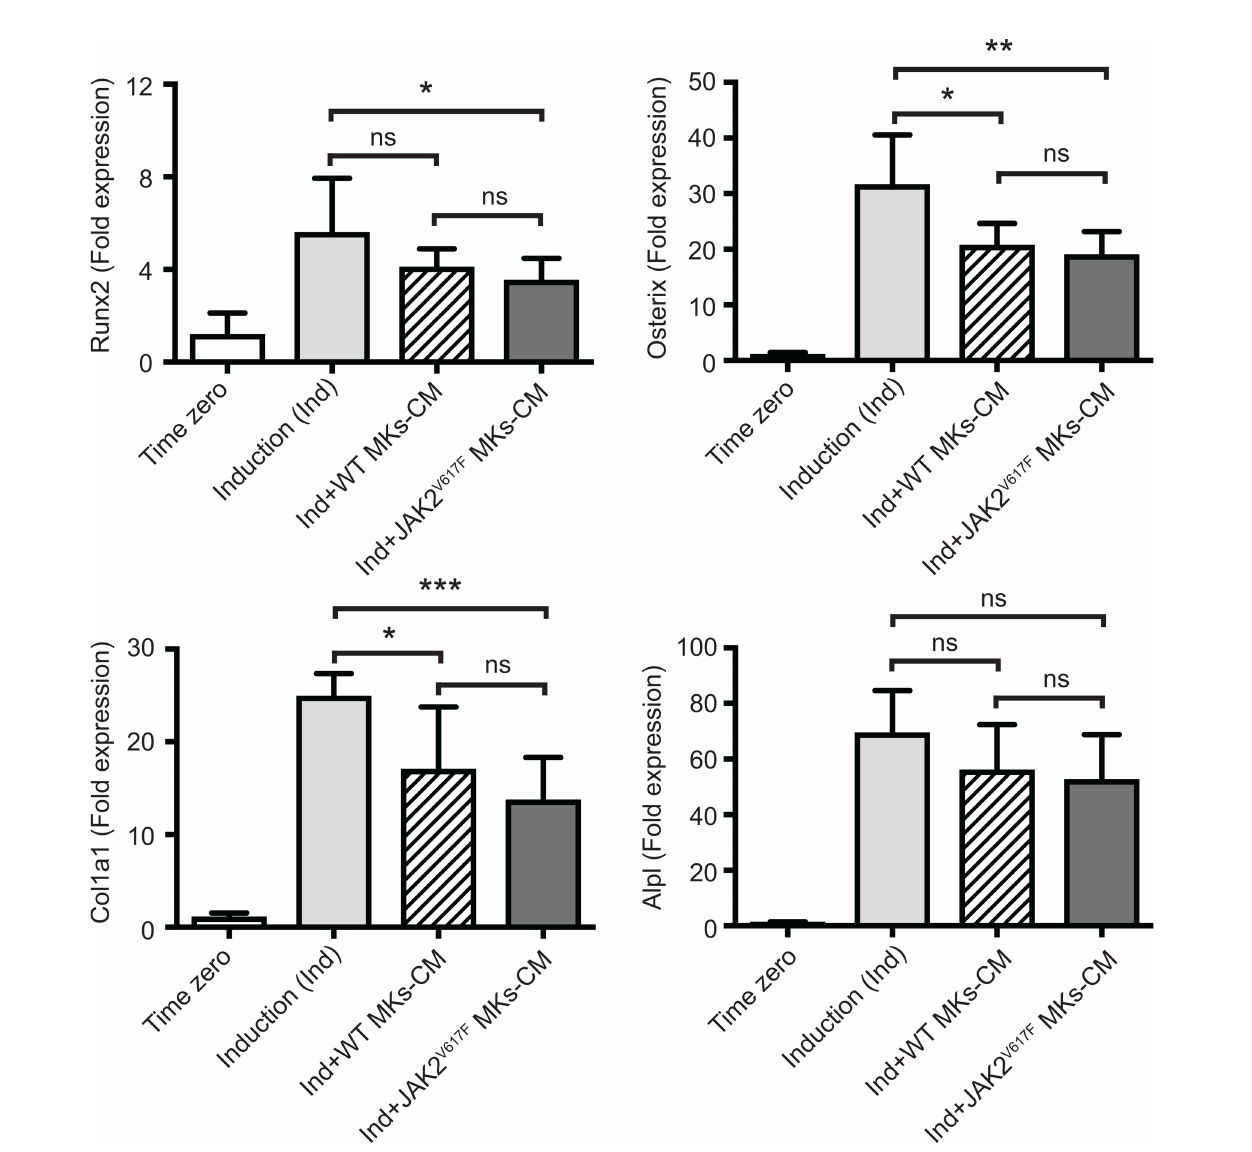
FIGURE 4 | Effect of MK-conditioned medium (CM) on the OB differentiation program. Bone marrow cells were cultured and differentiated towards OBs with an induction mix in presence or absence of MK culture supernatants derived from JAK2 V617F mutated or control WT cultures, as described under methods. RNA was isolated from differentiating OBs and quantitative RT-PCR was carried out to detect expression of OB differentiation markers, Runx2, Osterix, Col1a1 and Alpl. Data were normalized to 18S rRNA and values were compared to time zero, where this point refers to samples that were isolated right before the beginning of induction of OB differentiation. Results shown are averages of 2 biological repeats, each done in triplicates, and for each, several mice were pooled. For the OB culture, a total of twenty fi ve 13 weeks old control male mice were used, and MKs were derived from a total of twenty three or twenty six control or JAK2 V617F male mice, respectively, each 18 weeks old. P-values were generated with an unpaired two-tailed t-test. *Denotes p<0.05; **Denotes p<0.01; ***Denotes